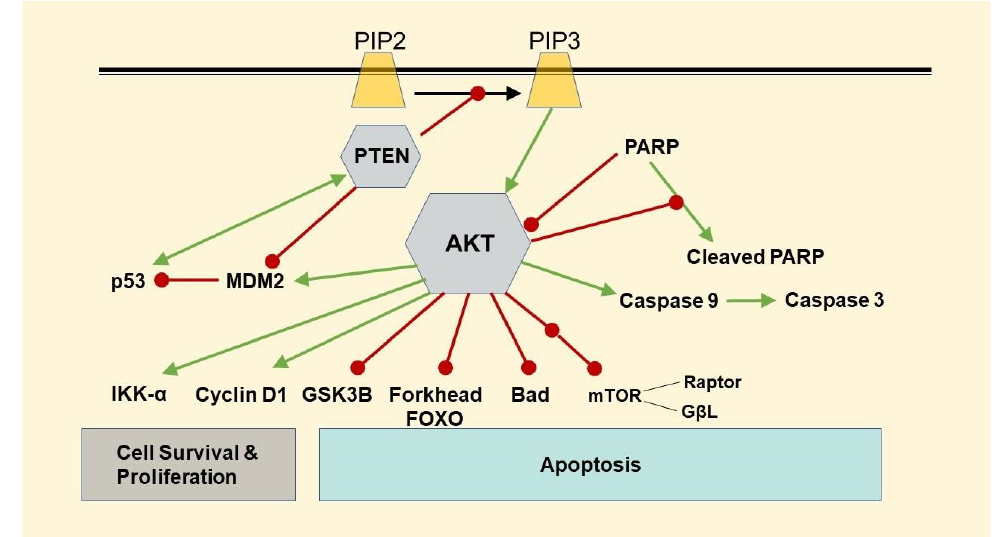
Figure 1. Schematic representing the relationship between proteins associated with apoptosis. Abbreviations: PIP2—phosphatidylinositol 4,5-bisphosphate; PIP3—phosphatidylinositol 3,4,5- trisphosphate; PTEN—phosphatase and tensin homolog; AKT—Ak strain transforming; GSK3 β — glycogen synthase kinase 3 beta; IKK- ɑ —IkappaB kinase; MDM2—mouse double minute 2 homolog or E3 ubiquitin-protein ligase; PARP—poly (ADP-ribose) polymerase; mTOR—mechanistic target of rapamycin; Bad—Bcl-2-associated death promoter. Green arrows represent stimulation and red arrows represent inhibition.